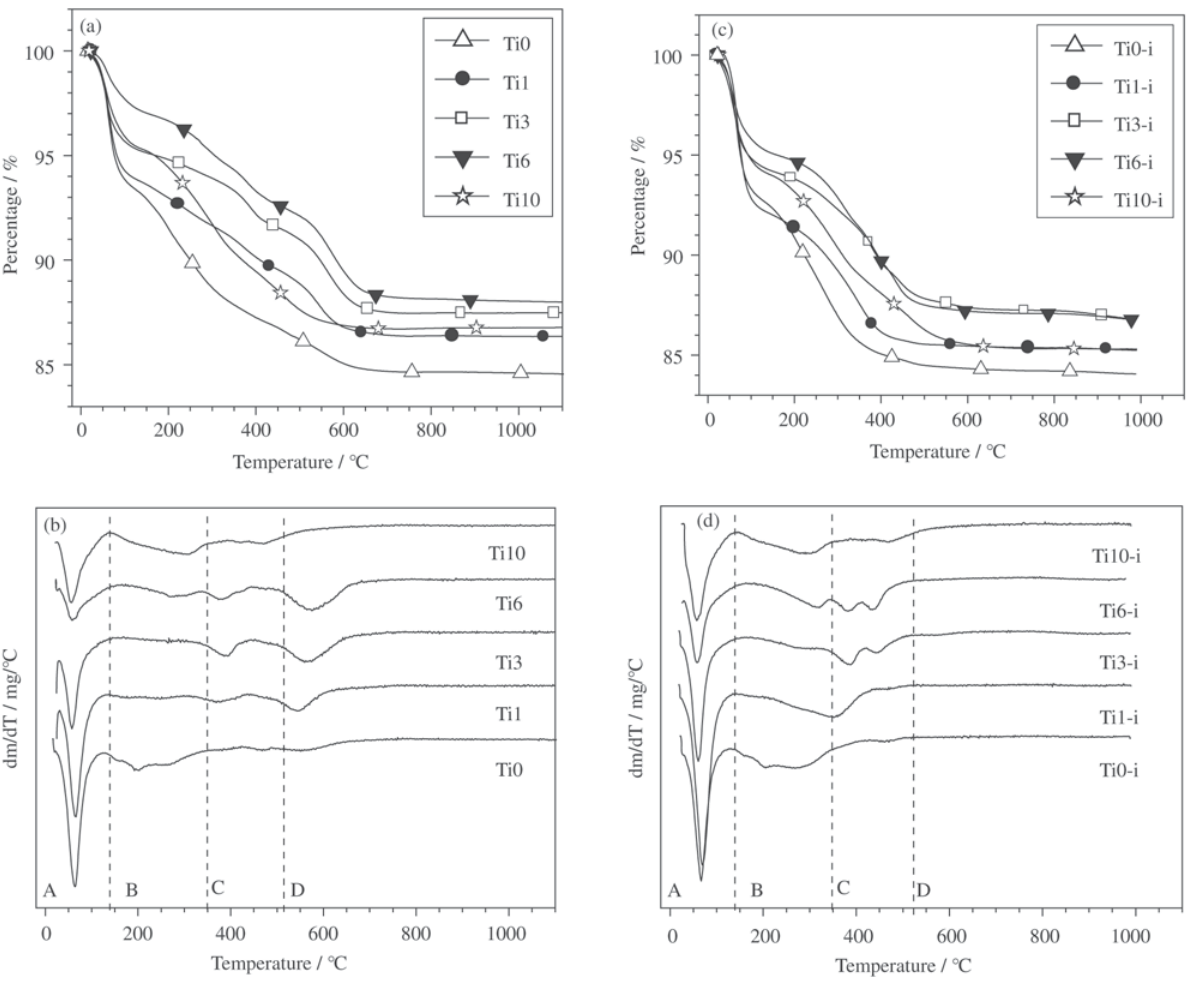
Figure 8. Thermograms of TAPO-5 in oxidant atmosphere: a) TGA, b) corresponding DTG; and inert atmosphere: c) TGA, d) corre- sponding